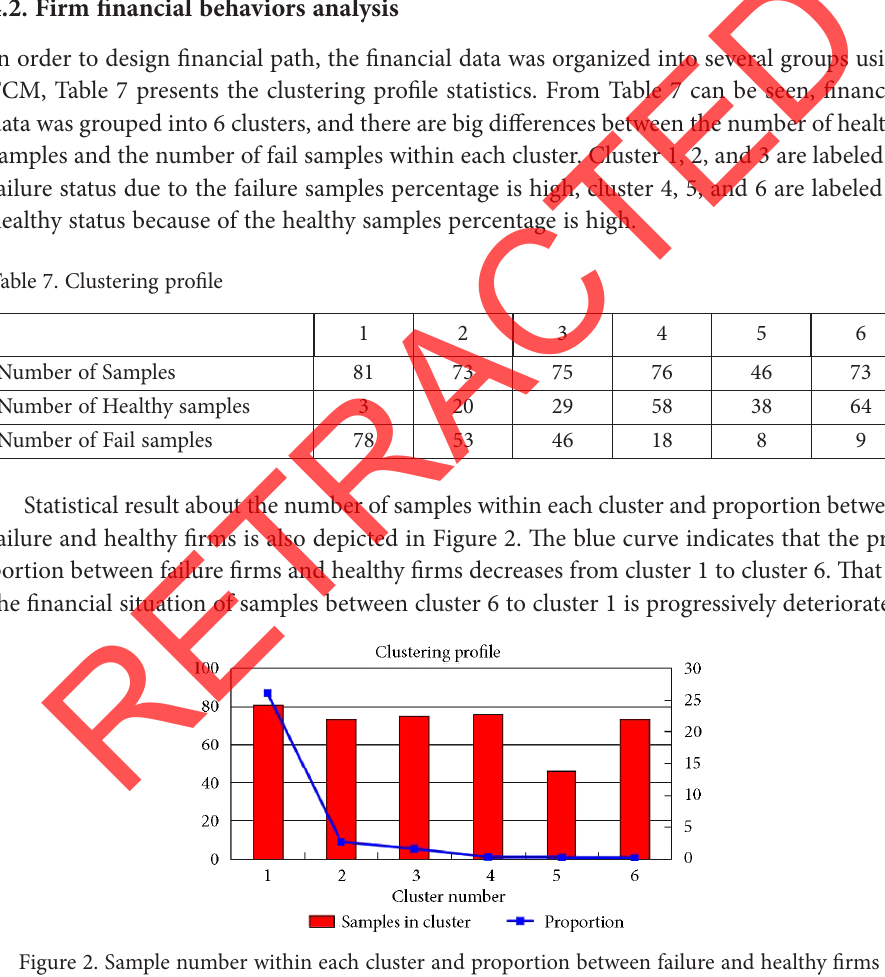
Figure 2. Sample number within each cluster and proportion between failure and healthy